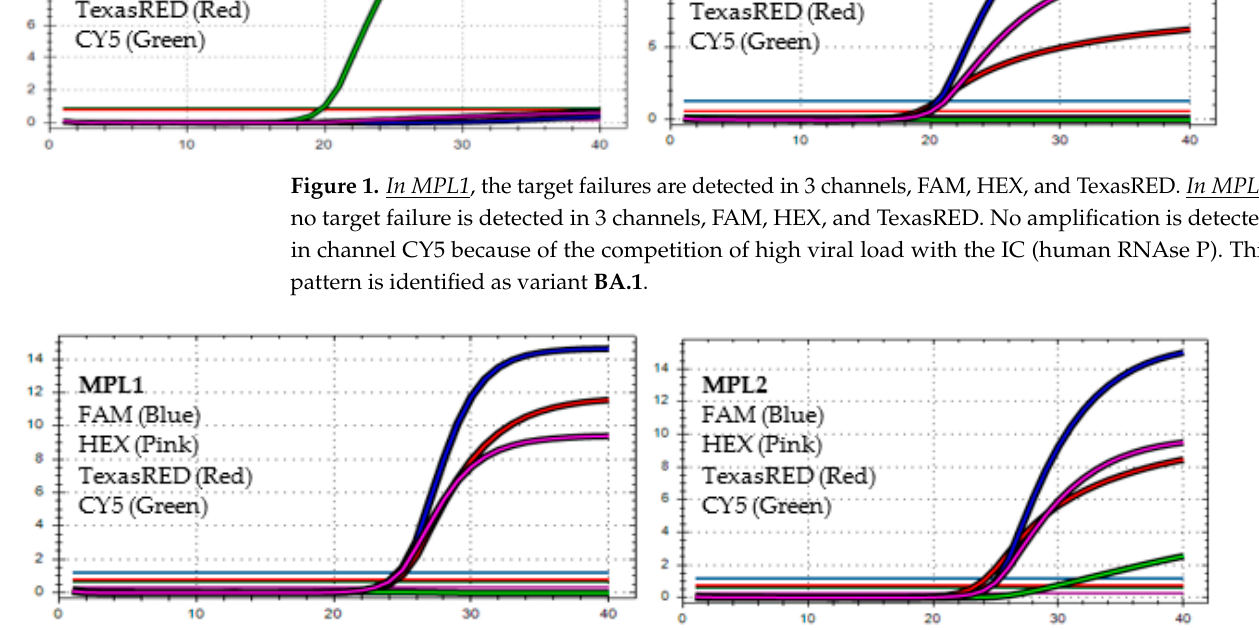
Figure 2. In MPL1 , the target failure is detected in channel CY5. In MPL2 , no target failure is detected in 3 channels, FAM, HEX, and TexasRED. The amplification detected in channel CY5 is weak because of the competition of high viral load with the IC (human RNAse P). This pattern is identified as variant BA.2